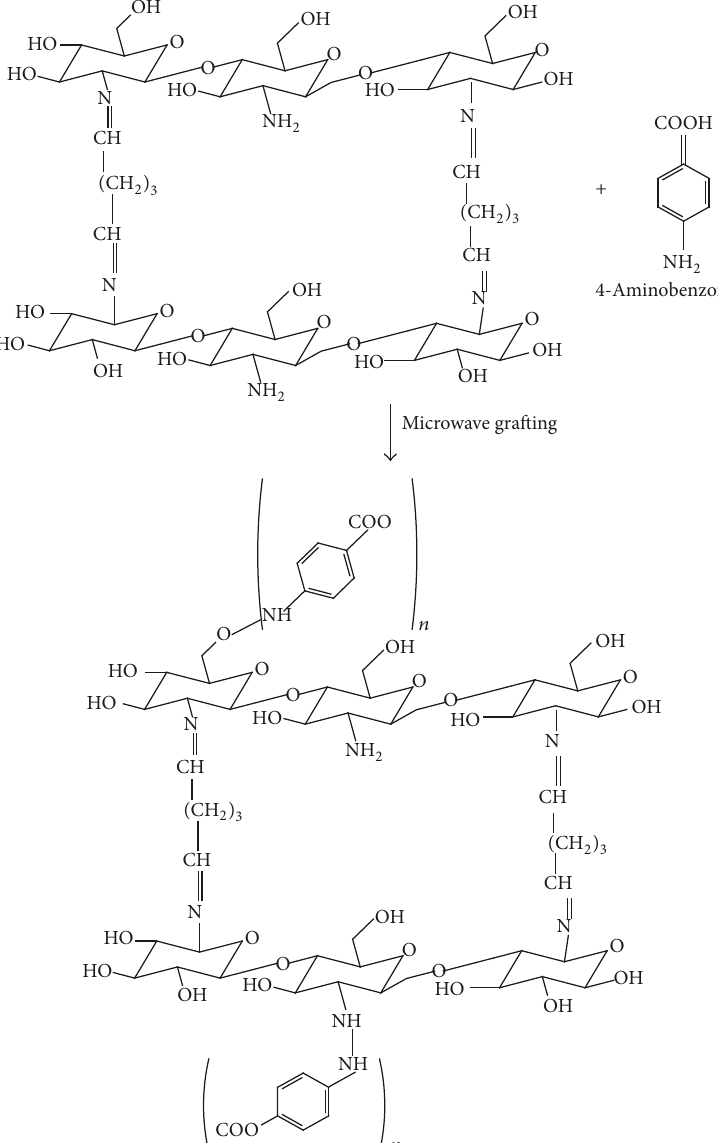
Figure 2: Schematic representation of the proposed structure of the grafting process of the cross-linked chitosan beads.